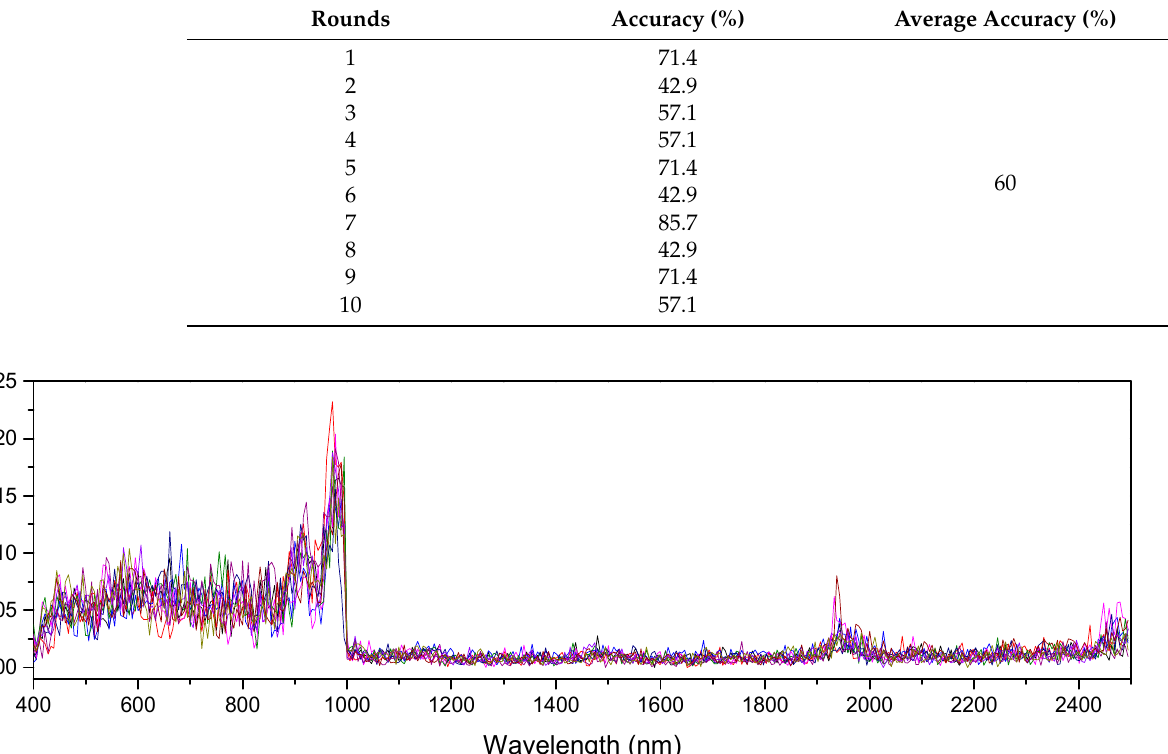
Table 2. The recognition accuracies under a one-year classification scale.